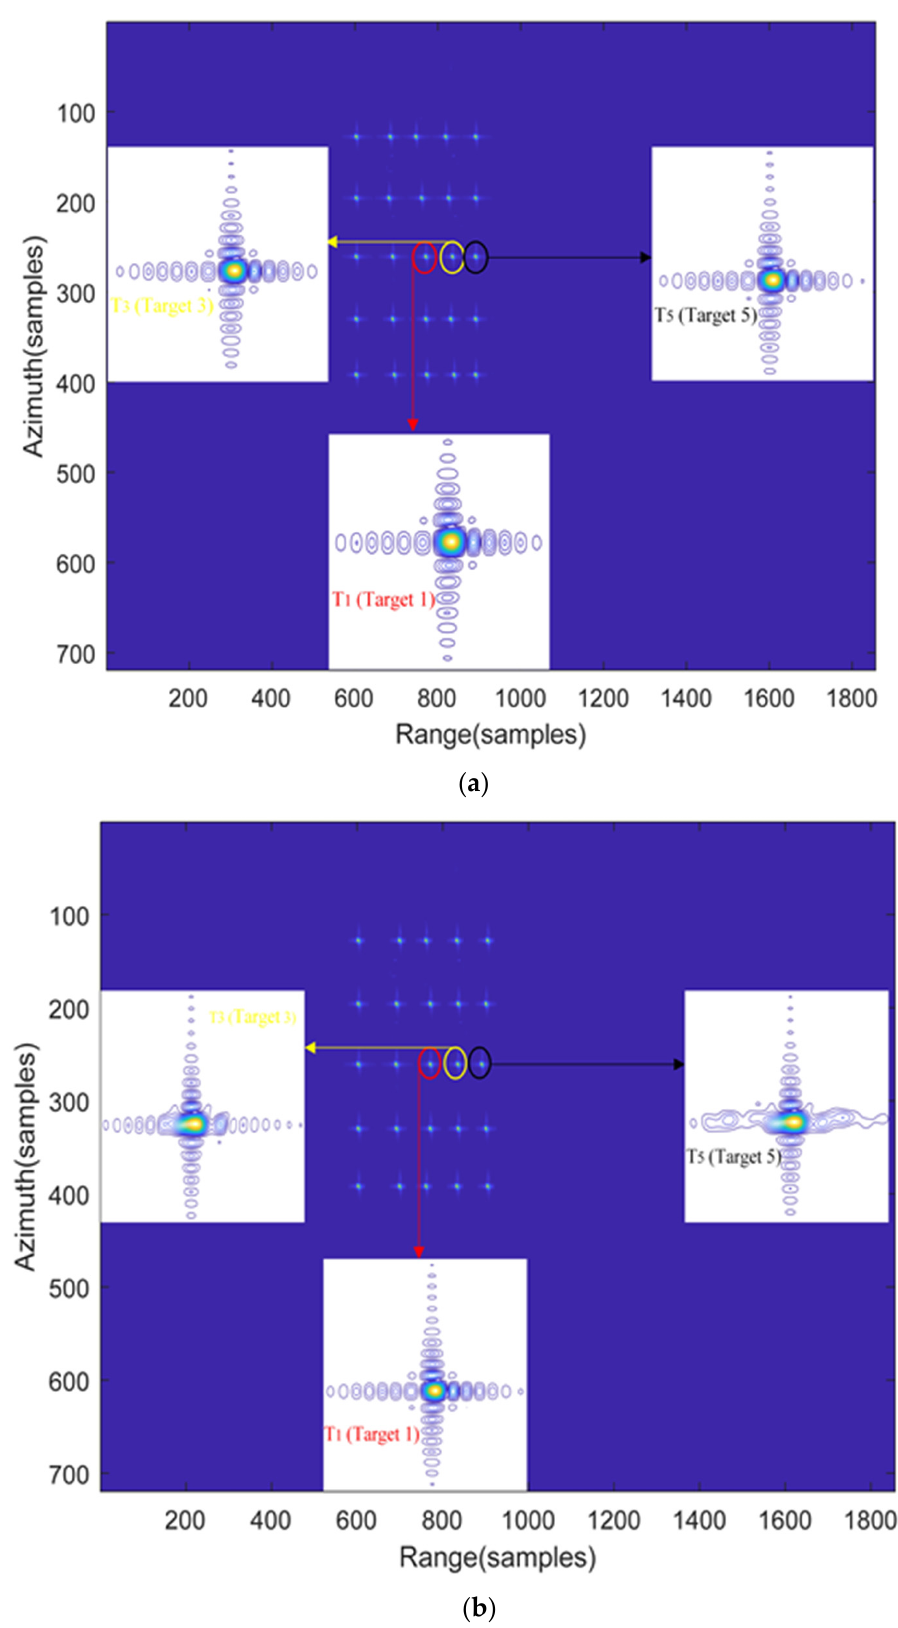
Figure 9. Imaging results of T 1 , T 3 , and T 5 points using the imaging algorithm. ( a ) The proposed algorithm; ( b ) the traditional algorithm.